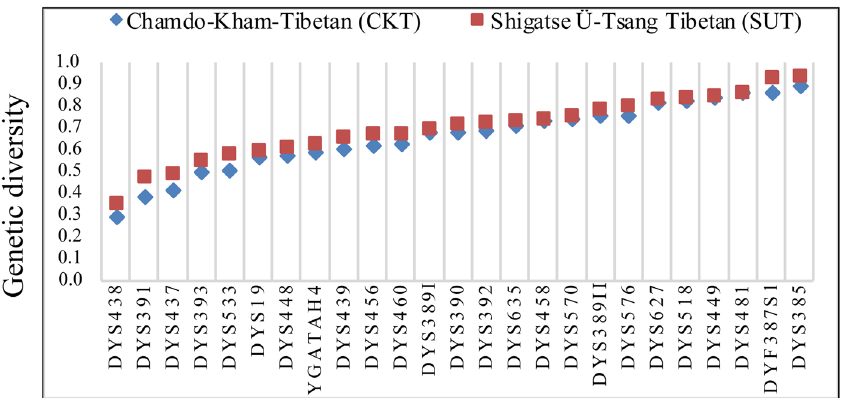
Figure 1. Genetic diversity (GD) of 27 Y-chromosomal STRs included in the Yfiler Plus amplification system in two studied Tibeto-Burman-speaking Ü-Tsang and Kham Tibetan